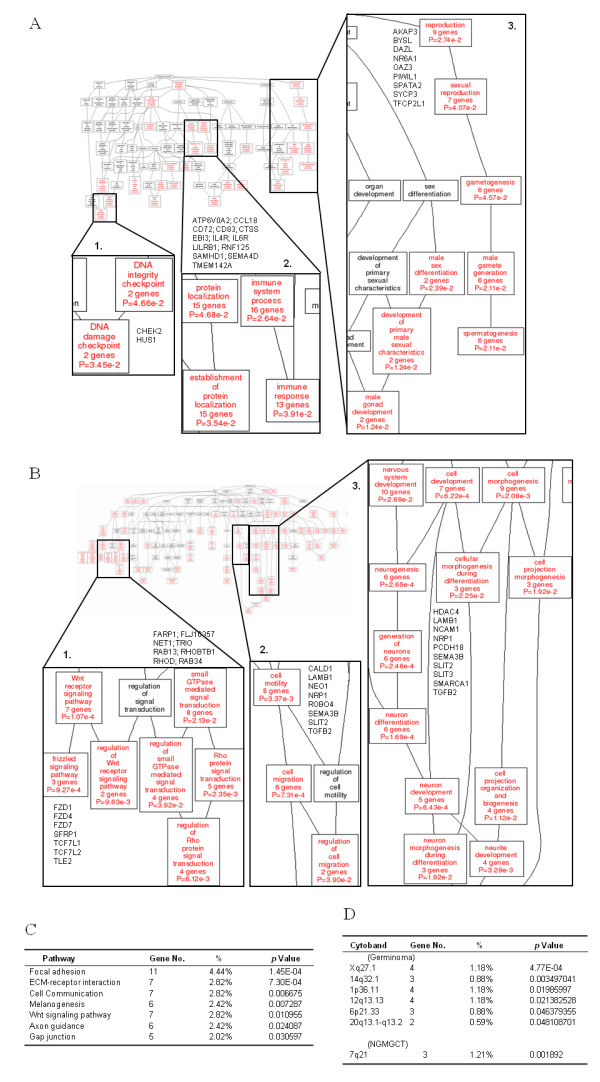
Altered functional modules in the different pediatric GCT prognostic groups. (A-B) Gene set enrichment analysis according to the Gene Ontology (GO) classification. Probe sets differentiating good prognostic CNS GCTs from intermediate/poor prognostic CNS GCTs were subjected to the GO database search via the DAVID 2008 interface. The number of genes, gene symbols, their percentages and the p values for each category that show significance (p < 0.05) and are enriched in either the good (A) or the intermediate/poor (B) prognostic group are listed. (C) KEGG pathways significantly enriched in the TW NGMGCT genes. The number of genes, their percentages in terms of total genes, and the p values for pathways that are significantly over-represented (p < 0.05 by the DAVID 2008 tool) are listed. (D) Distribution of signature genes on the chromosome cytobands.